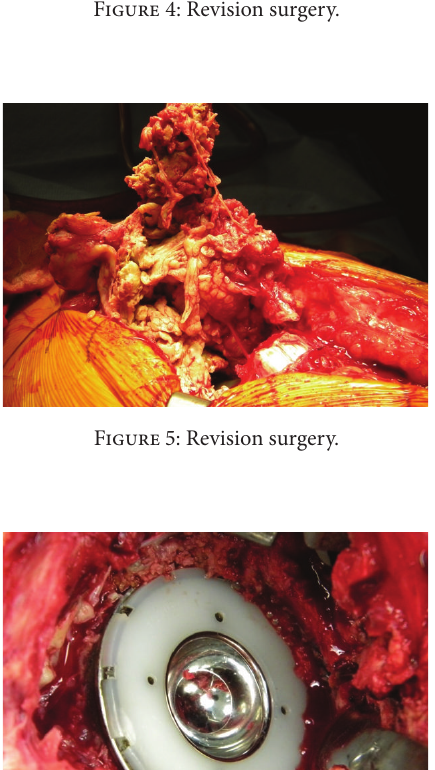
Figure 8: Pigment laden histiocytes not limited to vascular